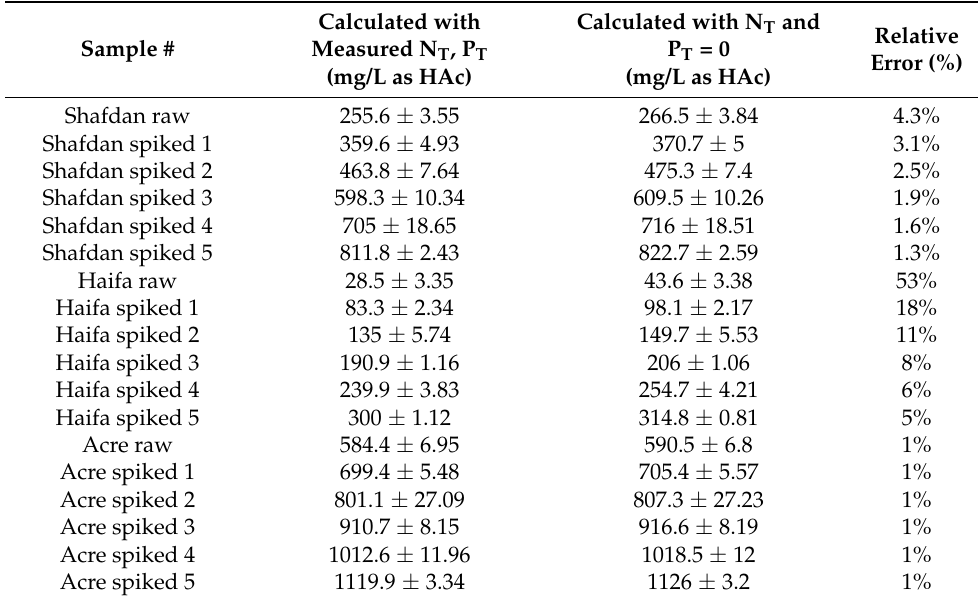
Figure 2. VFA T results obtained from applying the method to four (spiked) anaerobic digestion liquors (( a ): ● —Shafdan WWTP; ● —Haifa WWTP; and ( b ): ▲ —Acre WWTP; ▲ —Zichron winery digester). Table 3. Estimation of the error obtained in VFA T ’s calculation when N T and P T are ignored